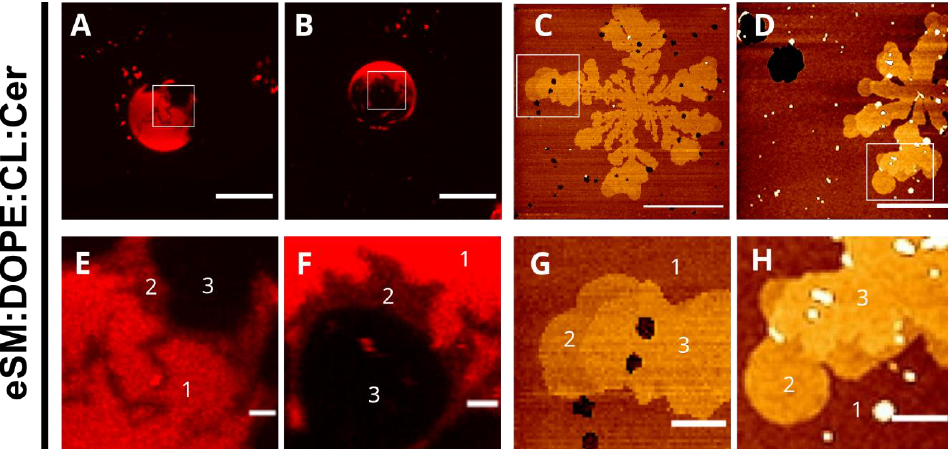
Figure 3. eSM:DOPE:CL:eCer (23:33:33:10) mixtures. The bottom images correspond to the white boxes in the top images but observed with a higher magnification. The top images are taken from Figure 2A bottom ( A , B ); and not shown ( C,D ). Confocal microscopy ( A , B , E , F ). Bars: A and B, 10 µ m, and E and F, 1 µ m. AFM ( C , D , G , H ). Bars: C and D, 5 µ m, and G and H, 1 µ m. Phases in the amplified fields: 1, continuous fluid phase; 2, minor rigid domain; 3, main rigid